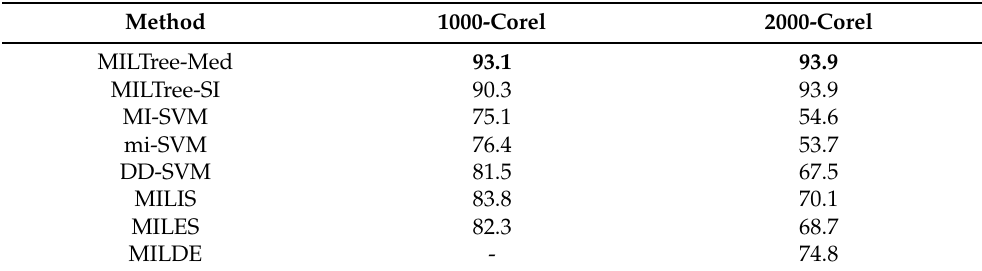
Table 8. Comparison between MILTree-SI / MILTree-Med and related methods from the literature on the 1000-Corel and 2000-Corel Datasets.